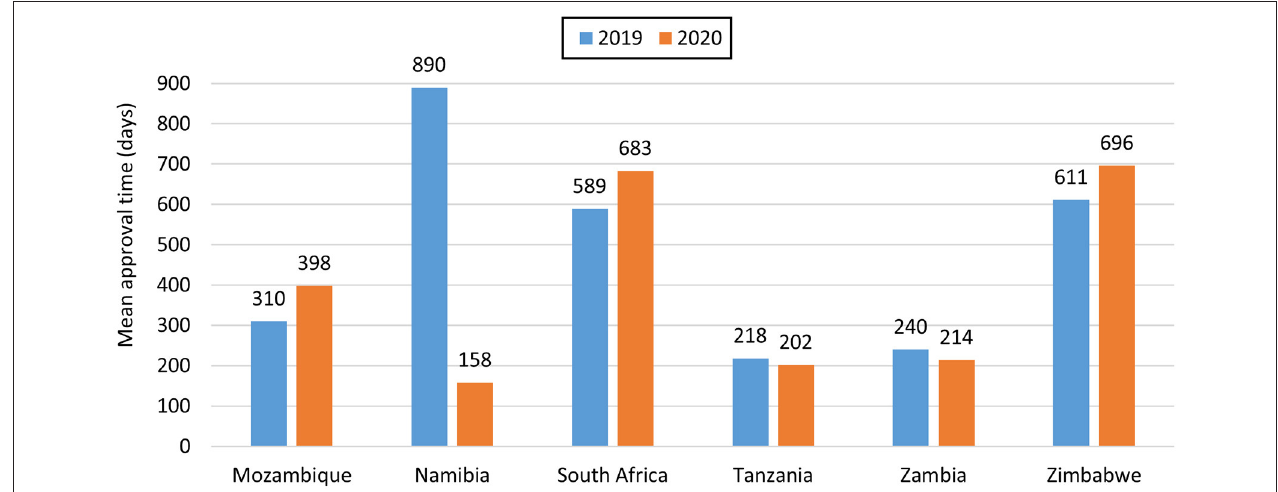
FIGURE 2 | Comparison of mean approval times for generics in 2019 and 2020.